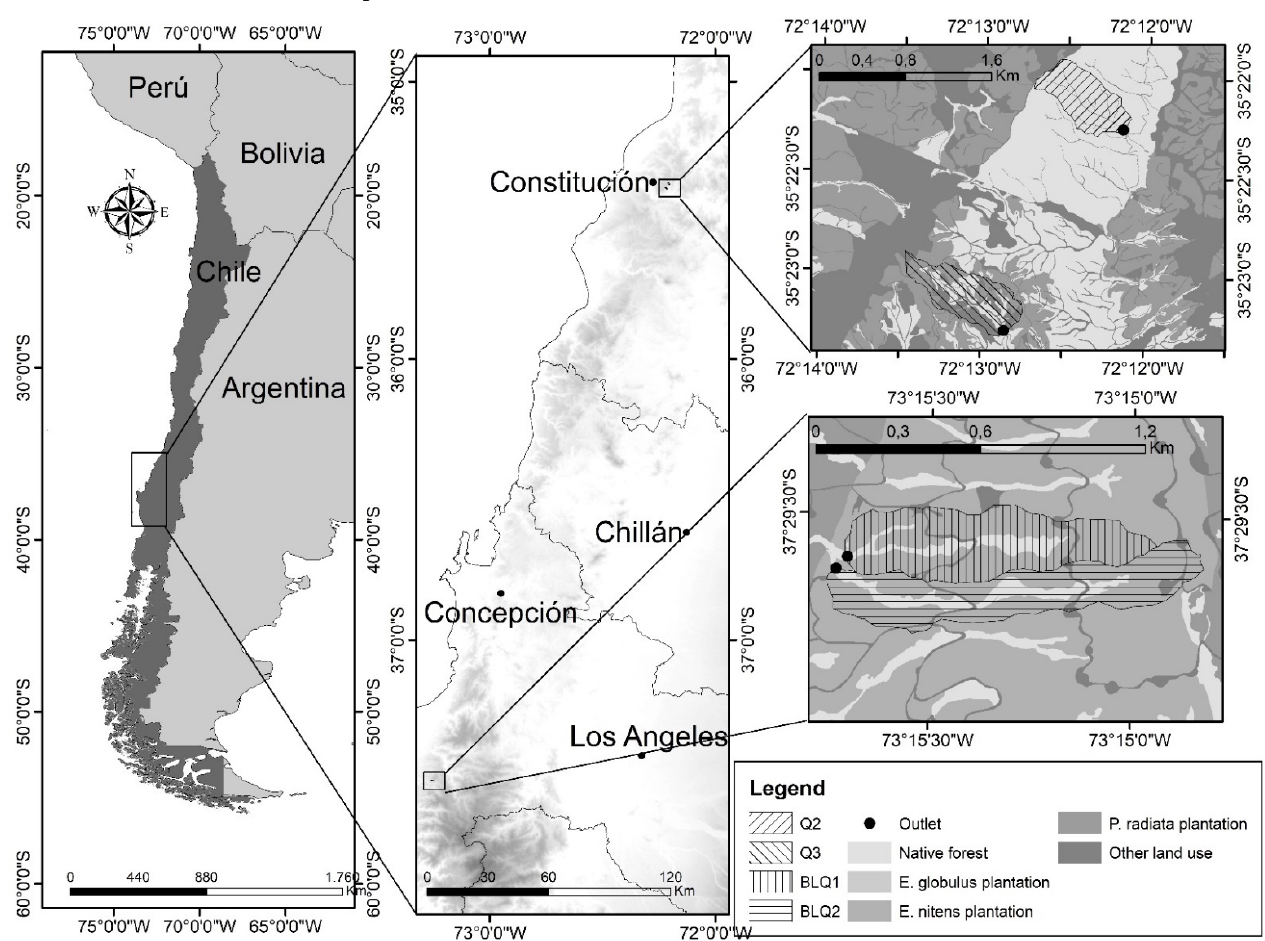
Figure 1. Geographical location of the catchments under study in south-central Chile.